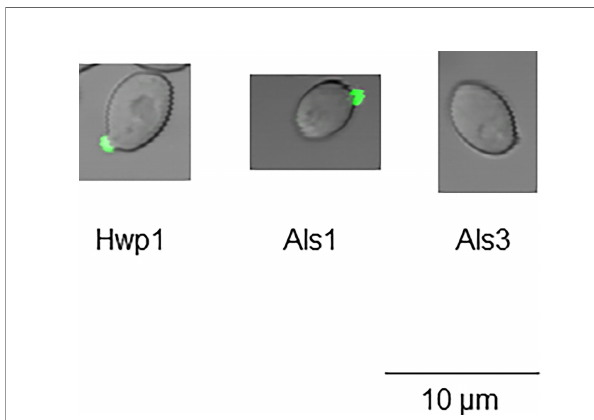
FIGURE 7 | Immunolabeling of C. albicans cells 10 min after placing them into RPMI 1640 medium to induce germ tube formation. C. albicans CAI12 was grown in YPD to saturation, then washed and placed into RPMI medium at 37°C and 200 rpm shaking. Cells were collected by fi ltration at various time points with a 10-min time point pictured. Immunolabeling with either anti- Hwp1 (left), anti-Als1 (center), or anti-Als3 (right) was used to follow the time course of protein detection on the surface of yeast cells at the earliest stages of germ-tube formation. At the 10-min time point, Hwp1 and Als1 were visible by immunolabeling while Als3 required additional incubation to produce a detectable signal.